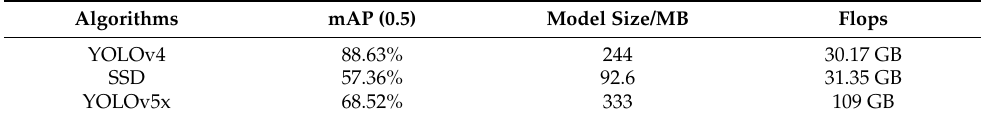
Table 2. YOLOv4 validity experiment results.